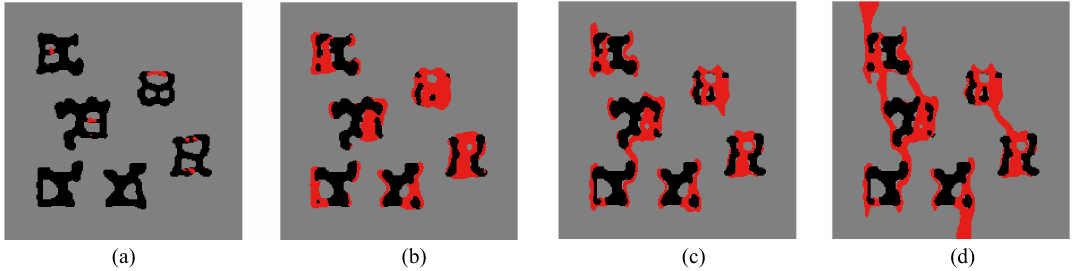
Figure 19. Crack propagation in the final composite without initial cracks subjected to loading case 1: